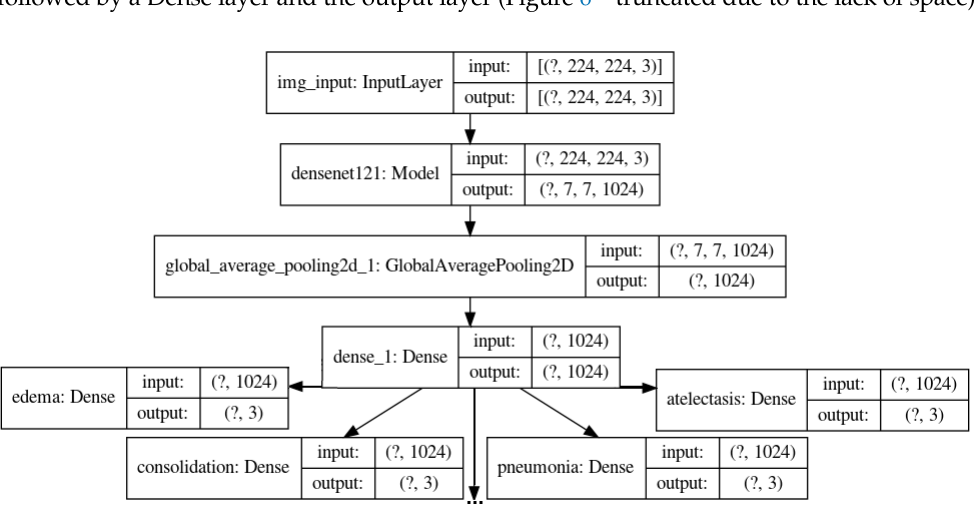
Figure 6. CheXpert-14 models: using DenseNet121 for training with 14 multi-outputs and 2 or 3 classes for each